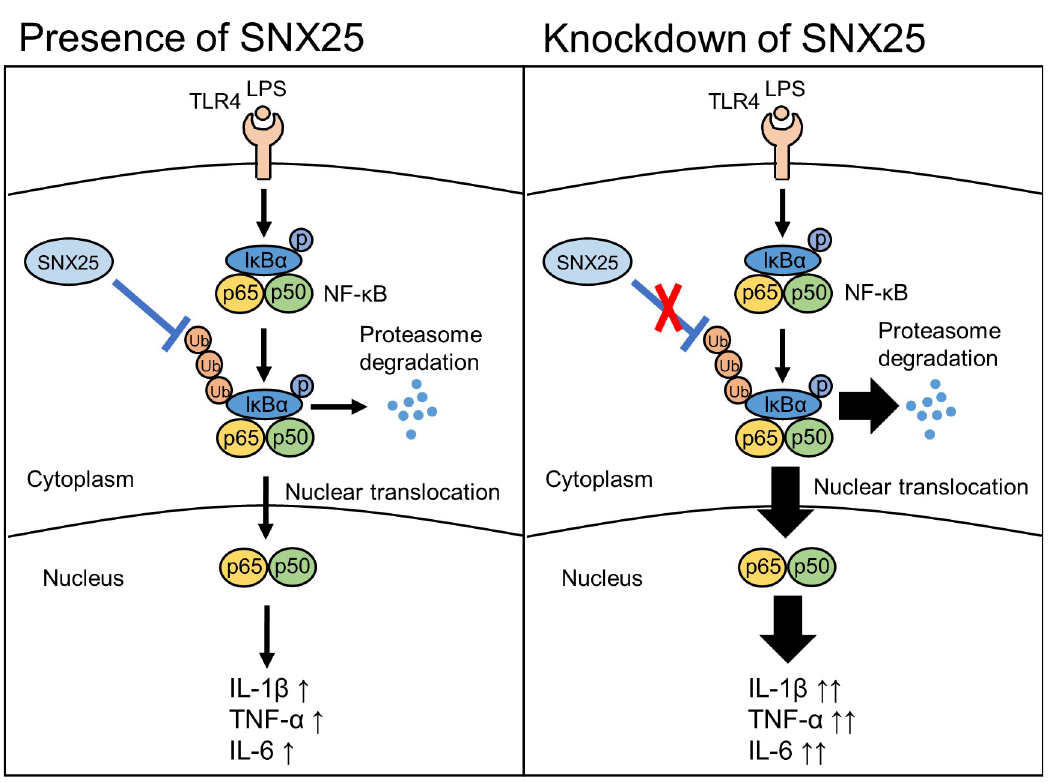
Fig 6. Model illustrating that SNX25 regulates proinflammatory cytokine expression by affecting I κ B α ubiquitination. SNX25 inhibits ubiquitination of I κ B α and the dissociation of I κ B α /NF- κ B (p65 and p50) complex and prevents nuclear translocation of NF- κ B and subsequent cytokine